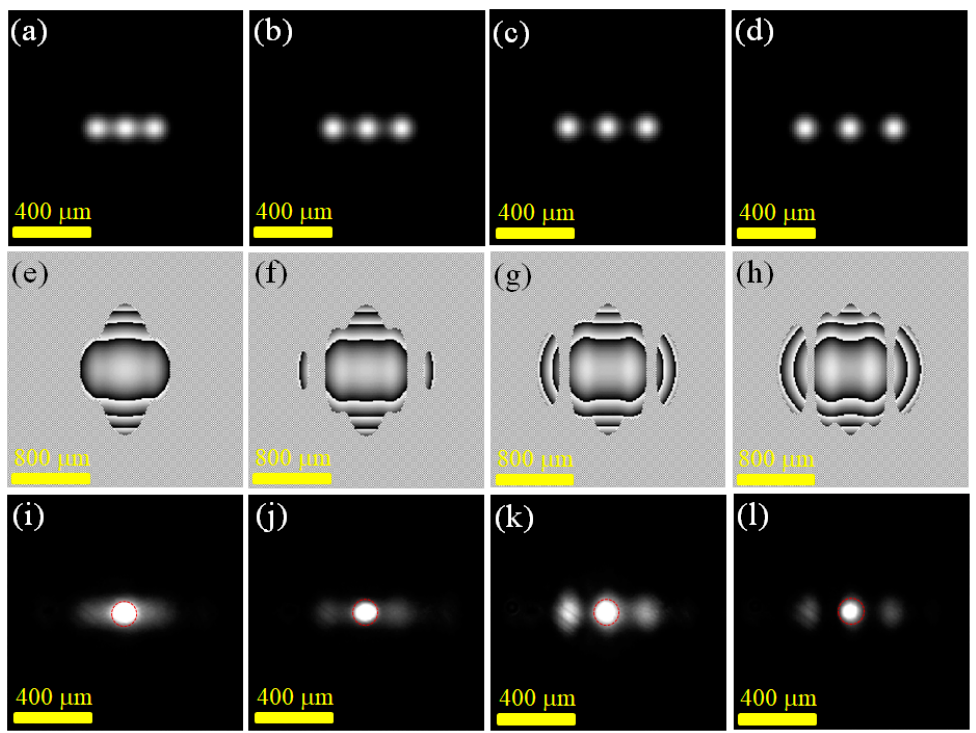
Figure 2. Experiments of generating 3-point light fields with different two-point spacings ( d ): ( a )–( d ) Calculated intensity, d = 150, 175, 200, and 225 µ m, respectively; ( e )–( h ) SLM projected phase diagram when d = 150, 175, 200, and 225 µ m, respectively; ( i )–( l ) Resulting field distribution when d = 150, 175, 200, and 225 µ m, respectively.